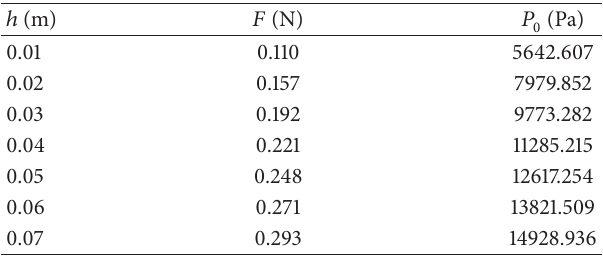
Figure 8: Deformation in one-dimensional stress